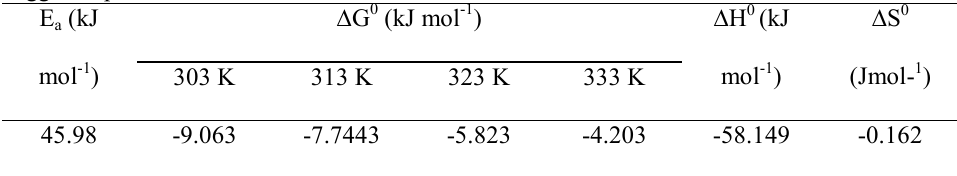
Table 5. Activation energy and thermodynamic parameters for adsorption of fluoride onto eggshell powder.